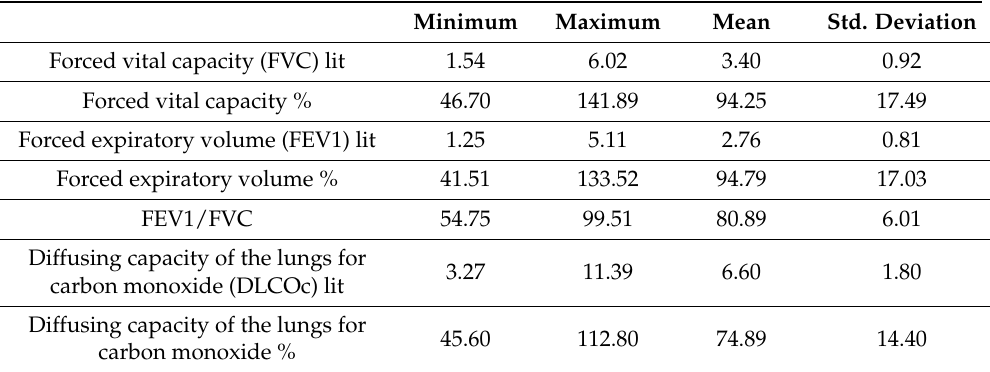
Table 2. Spirometry pulmonary function values.